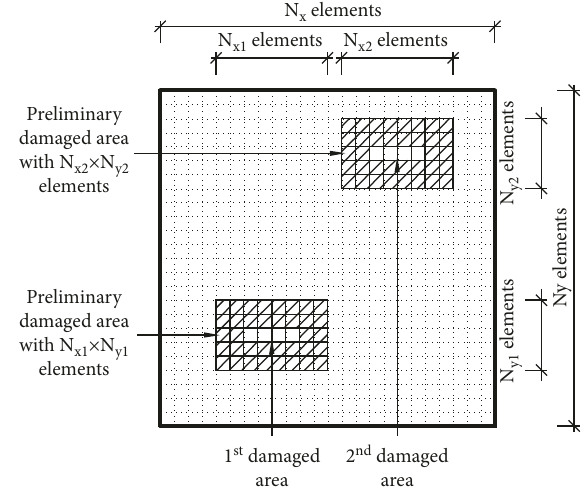
Figure 4: Illustration of the preliminary damaged